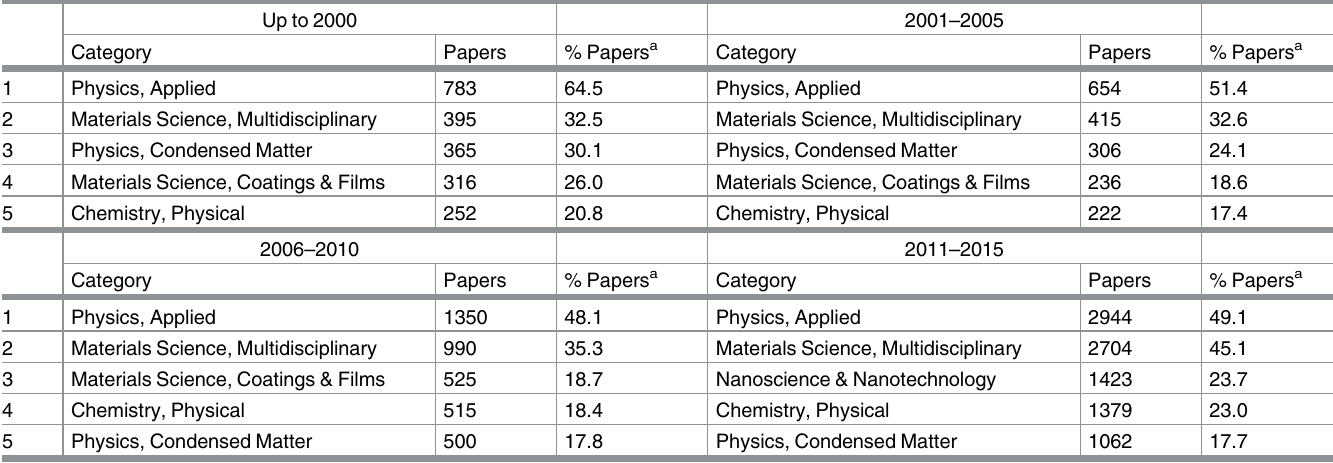
Table 3. Top 5 JCR categories by number of